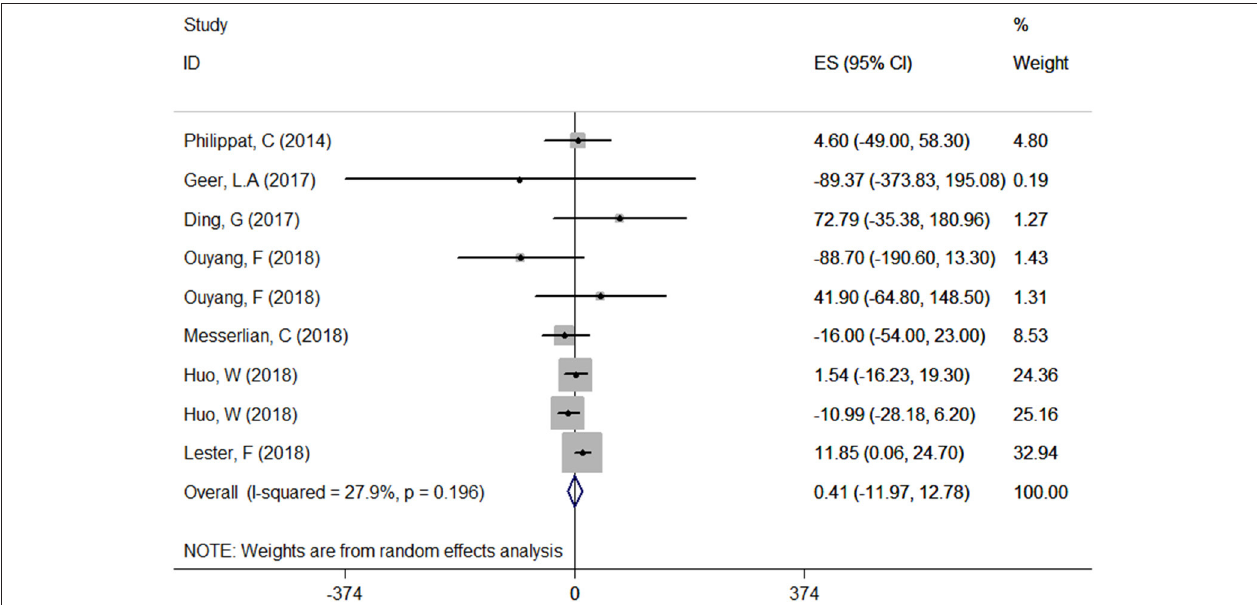
FIGURE 3 | Forest plot of TCS exposure during pregnancy and neonatal birth